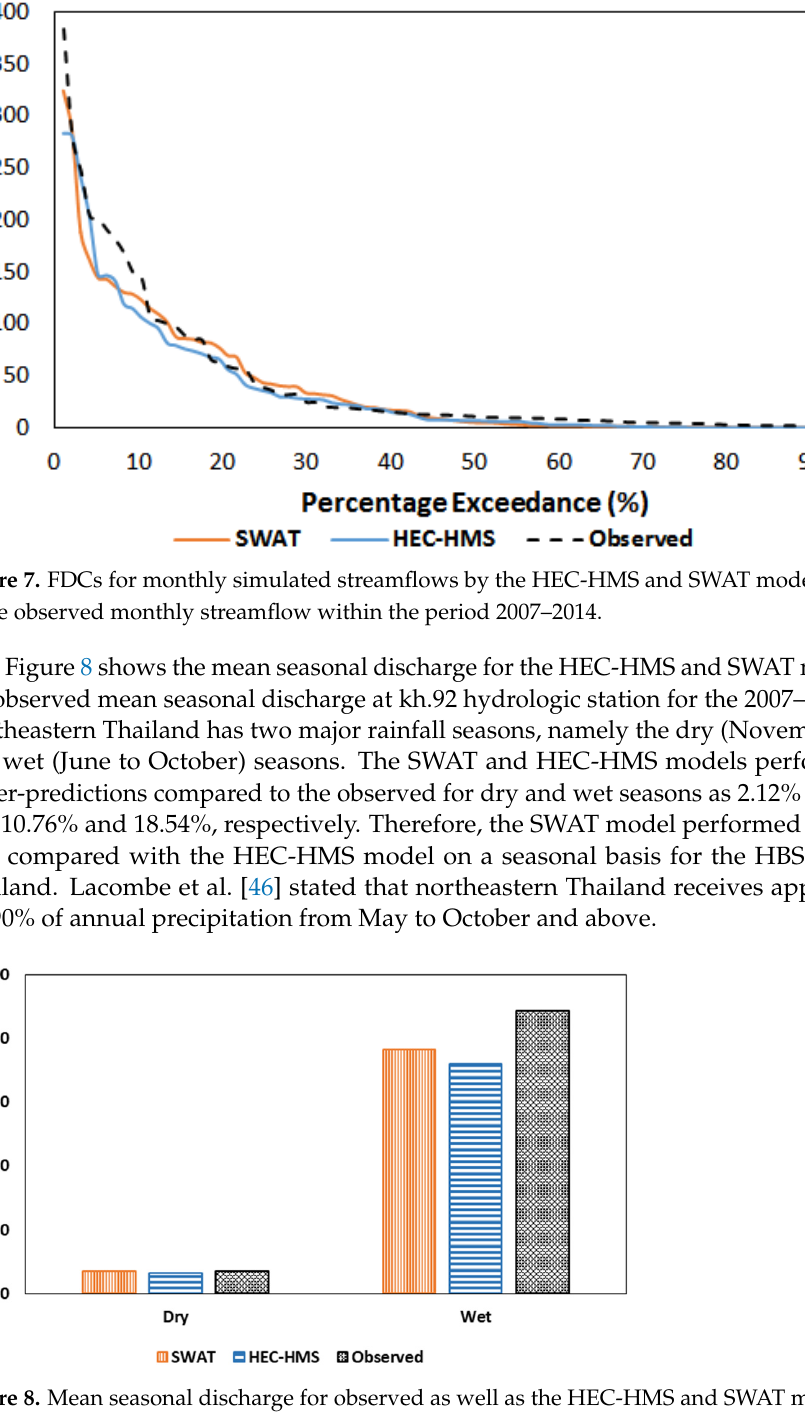
Simulated flow by SWAT model (mm) Calibrated flow (mm) Validated flow (mm) Linear (Calibrated flow (mm)) Linear (Validated flow (mm)) Calibrated and Validated flow (mm) Linear (Calibrated and Validated flow (mm))